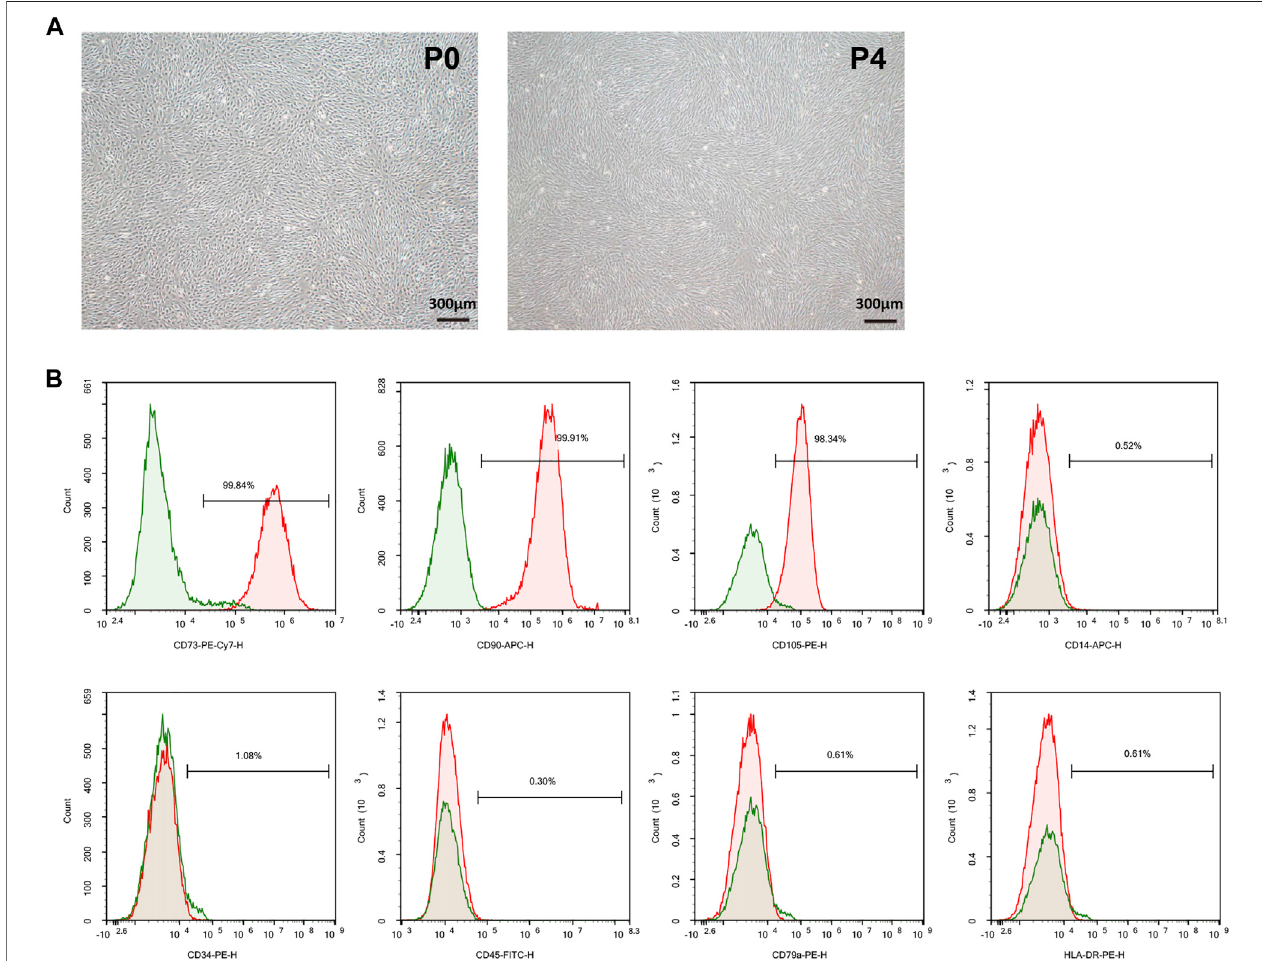
FIGURE1| Characterization ofhESC-derivedMSCs (A) RepresentativemicrographsofmorphologicalcharacterizationofMSCsatpassage0(P0)and passage 4 (P4) (B) Flow cytometry analysis for speci fi c surface antigen markers of MSCs at P4. hESC, human embryonic stem cell; MSC, mesenchymal stem cell.